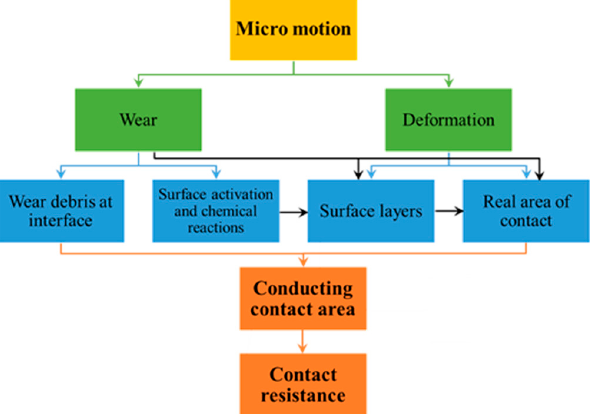
Figure 1. Influence of micro-motion causing tribological problems which affect contact resistance.